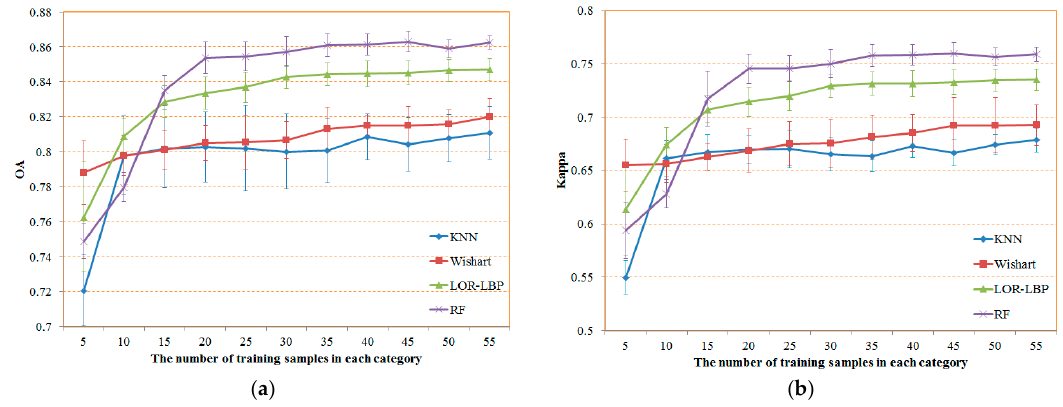
Figure 18. OA and Kappa curves with different numbers of training samples from the different classification algorithms: ( a ) OA; ( b ) Kappa.